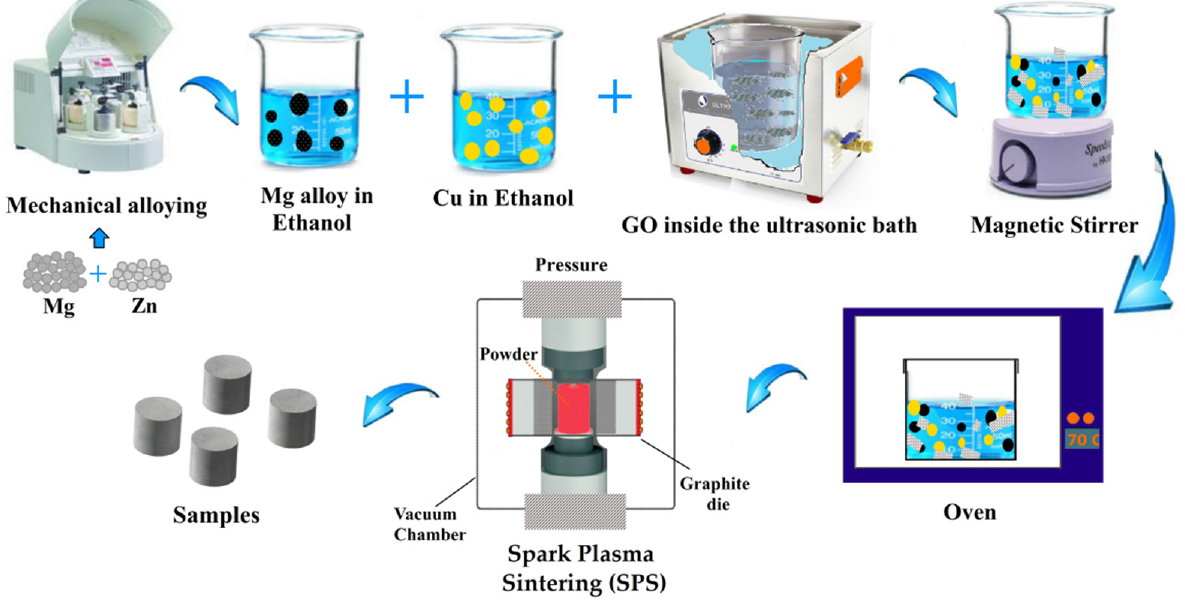
Figure 1. Illustration of the process of MZ/GO-Cu composite preparation using semi powder metallurgy and spark plasma sintering (SPS) methods.